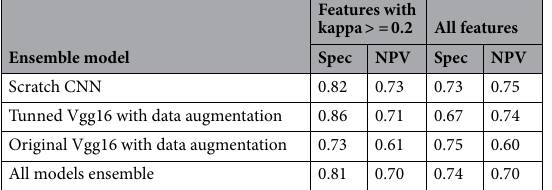
Table 10. The performance of ensemble model classification for the features with kappa > = 0.2 and all the features (specificity and negative predictive value